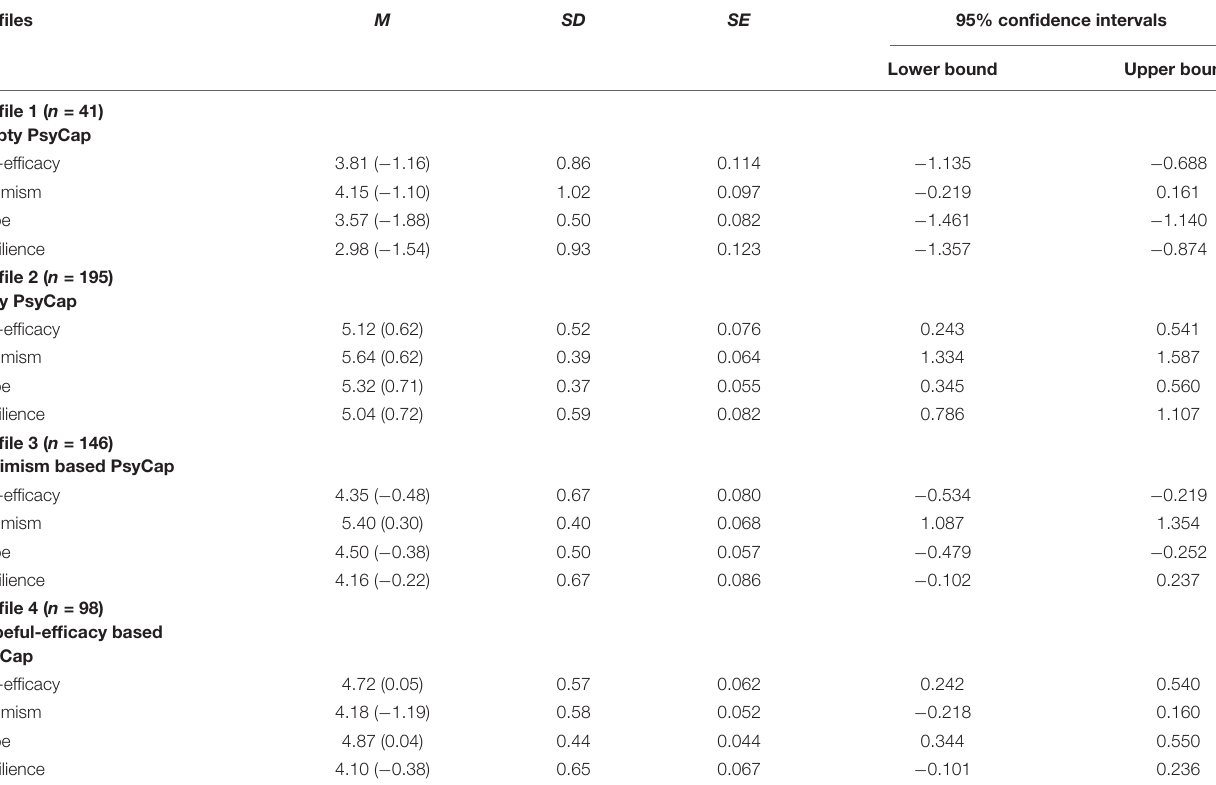
SD SE 95% confidence intervals Lower